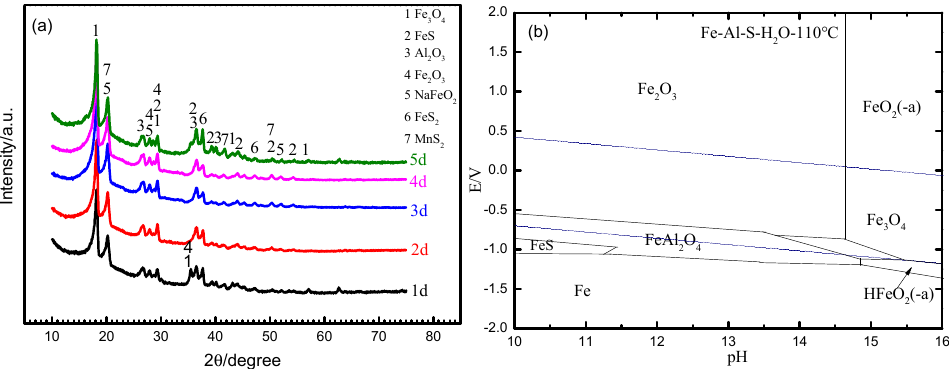
Figure 4. XRD analysis of the Q235 steel surface corrosion products with different corrosion times ( a ) and E-pH diagram of Fe–Al–S–H 2 O at 110 °C ( b ). Figure 4b is E-pH graph of Fe–Al–S–H 2 O at 110 °C derived from the HSC Chemistry